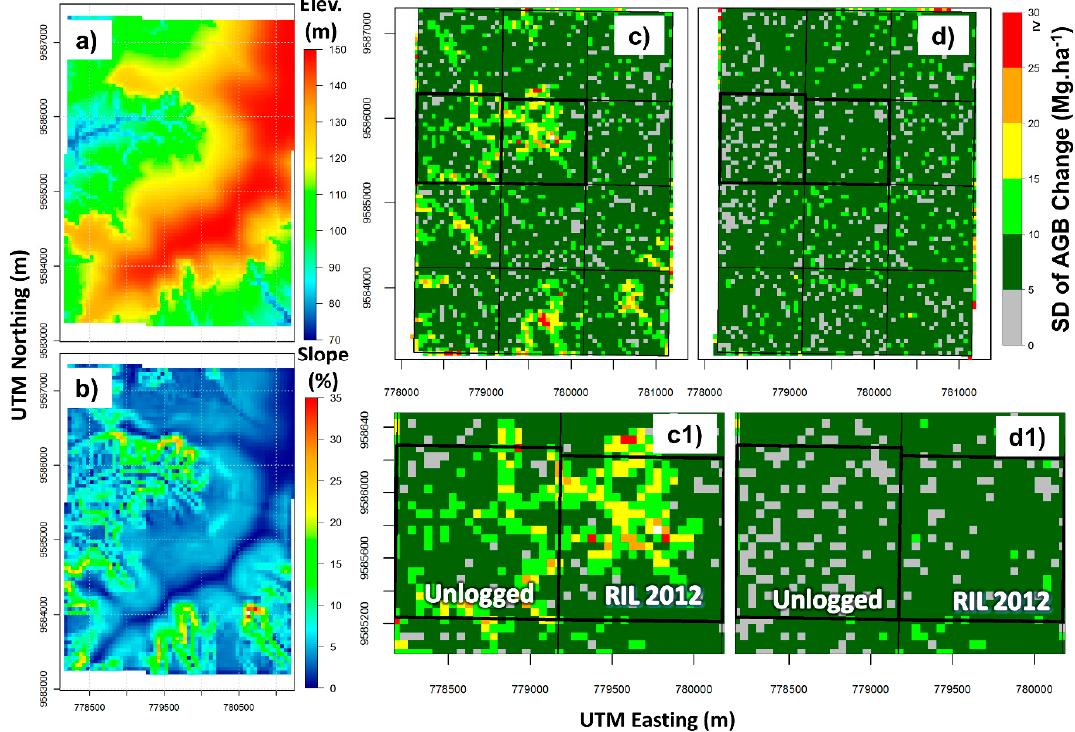
Figure 8. Digital terrain model ( a ) and Slope (%) ( b ) maps of the study area at 12 pulses · m − 2 in 2012; Standard deviation of AGB change at 0.2 pulses · m − 2 for DS1 ( c – c1 ) and DS2 ( d – d1 ).